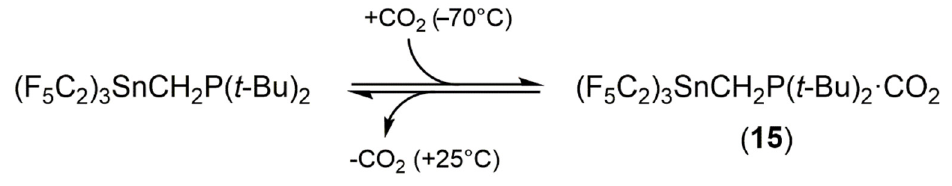
Scheme 22. Reaction scheme leading to Compound 15 , data from [70].